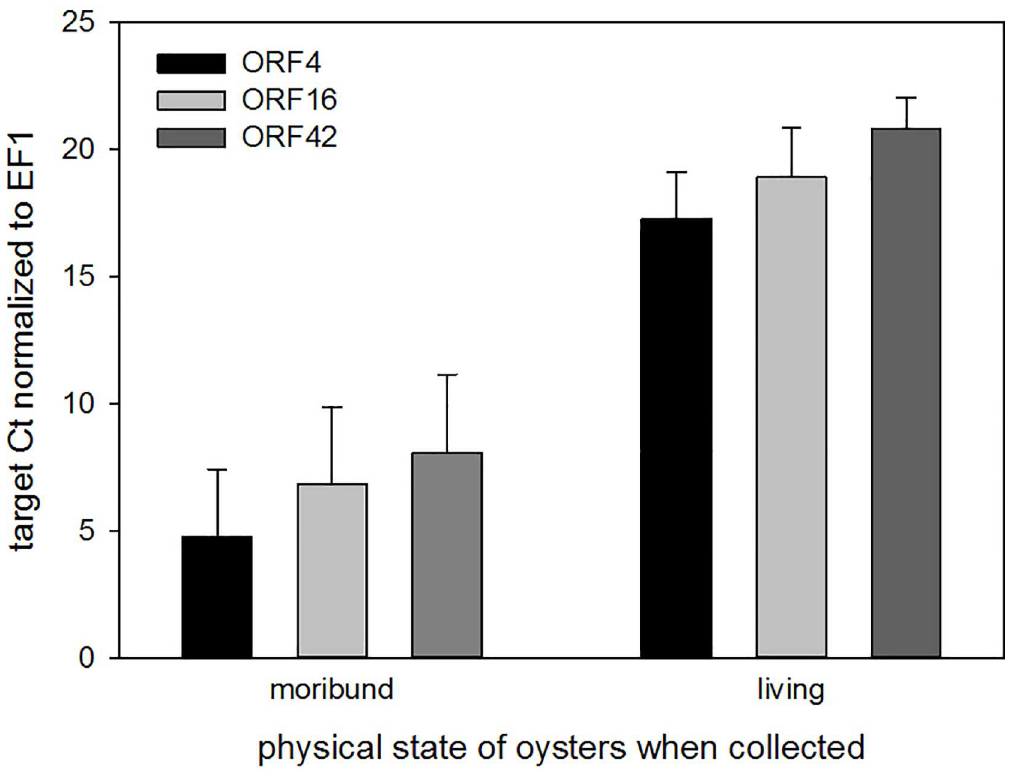
Fig 6. Relative expression of the 3 viral gene transcripts (ORF4, ORAF16, ORF42) in moribund and living oysters. Ct results (mean ± SD) are normalised to EF1. Lower Ct values correspond to earlier detection (higher expression levels) of each transcript. A total of 12 moribund oysters and 12 living oysters were